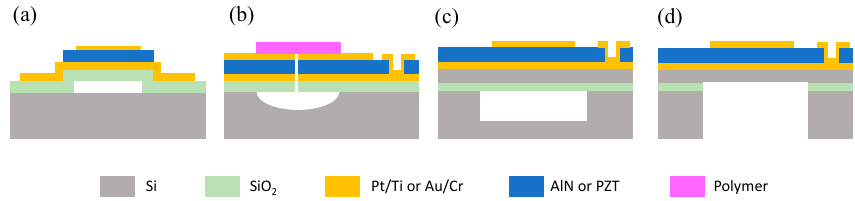
Figure17. Cross-sectionschematicofpMUTs showingthemembranesfabricatedwith ( a )sacrificial layer releasing, ( b ) front-side etching, ( c ) cavity silicon-on-insulator (SOI) wafer bonding, and ( d ) backside deep reactive ion etching